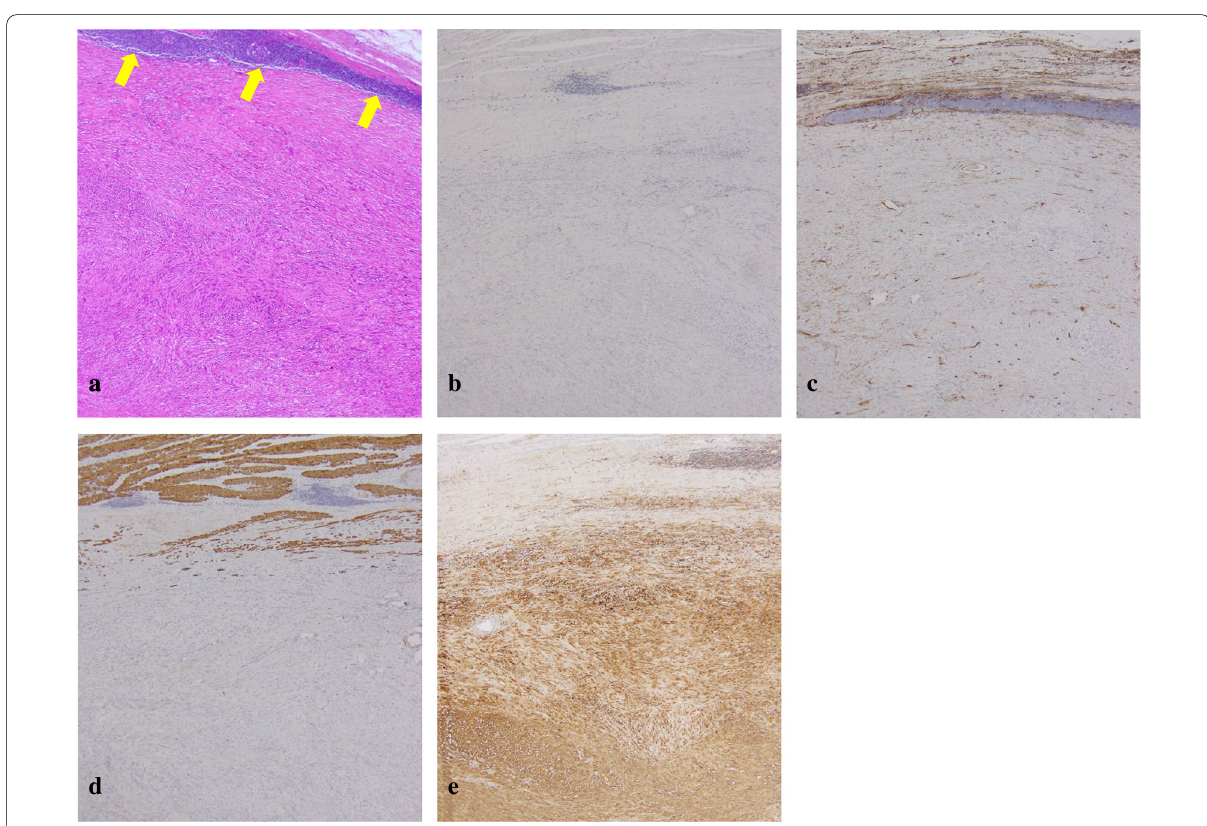
Fig. 3 a Hematoxylin–eosin staining demonstrating a bundle‑like growth of the spindle‑shaped tumor cells with acidophilic cytoplasm. A peritumoral lymphoid cuff is recognized (yellow arrows). b – e Immunohistochemical staining revealing that the tumor is negative for KIT ( b ), CD34 ( c ), and desmin ( d ) and positive for S‑100 protein ( e